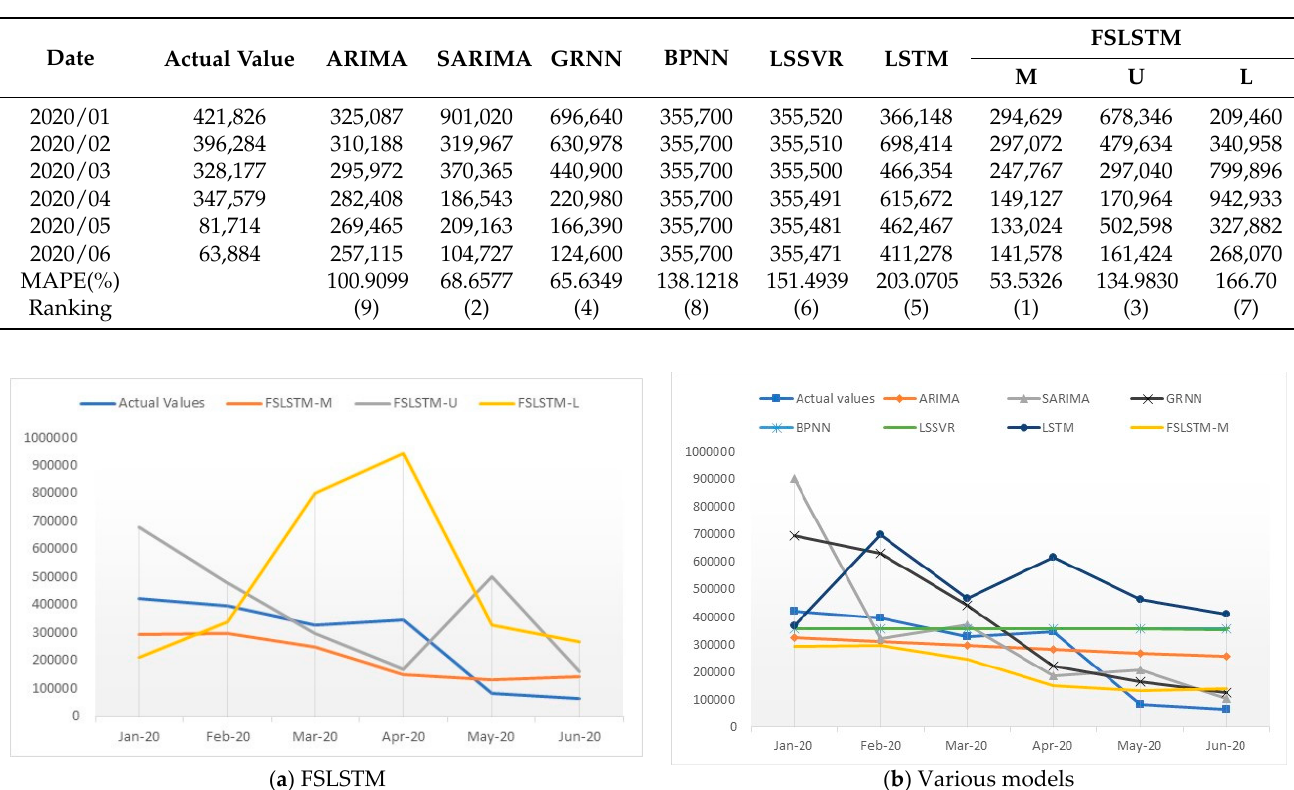
Table 6. Comparison of the forecasting results for the Taichung wind power plant.